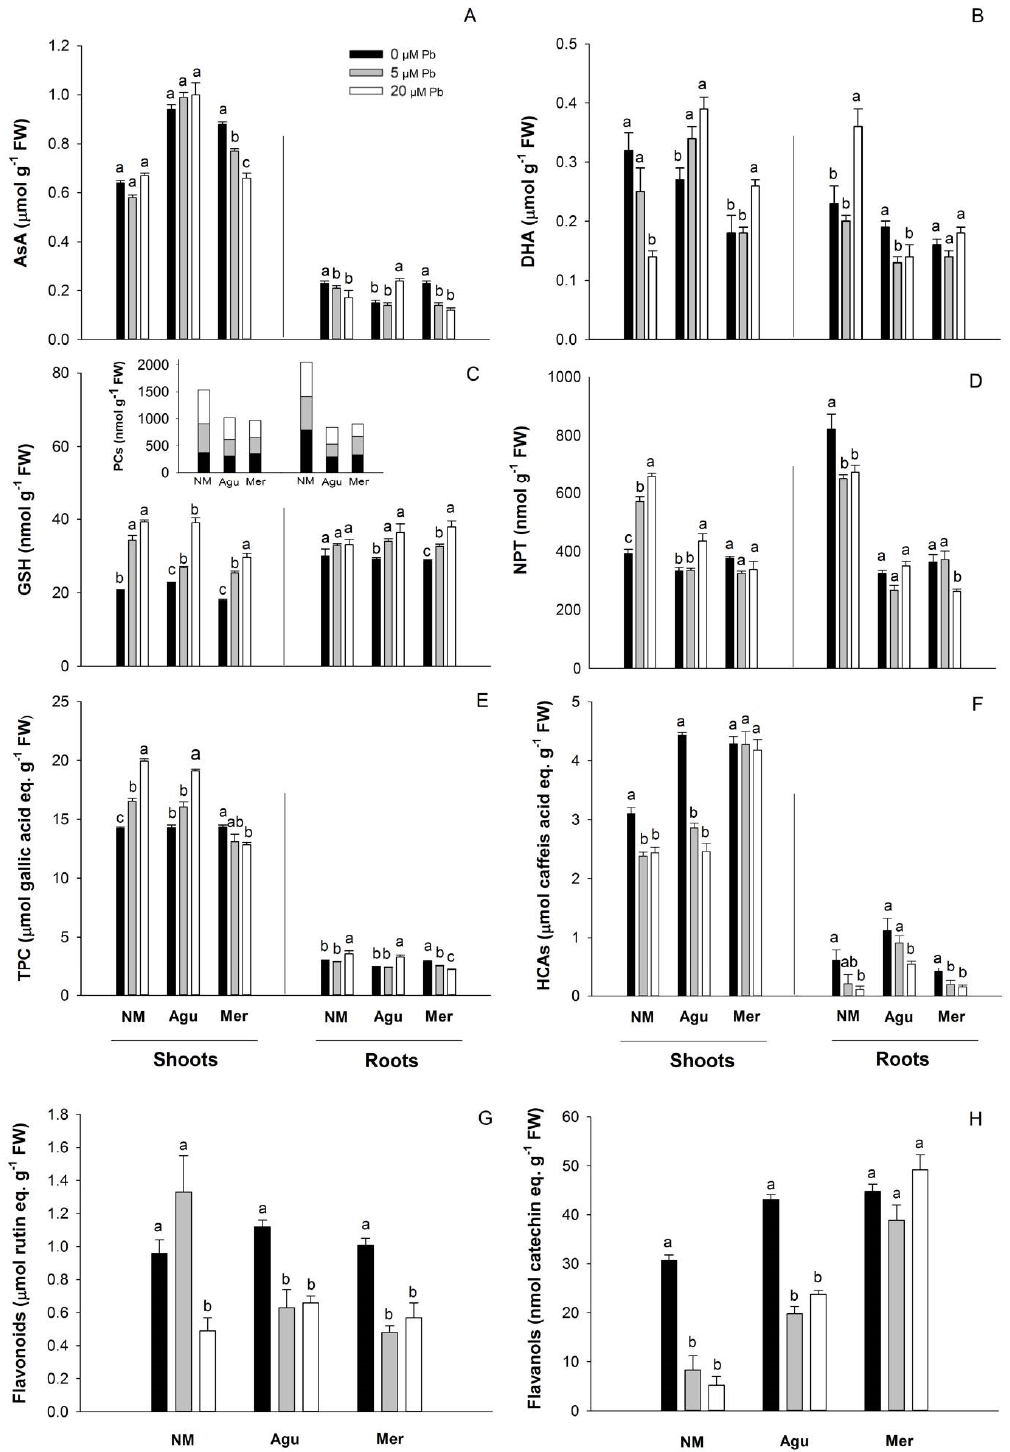
Figure 6. Redox profiles of the nonmetalliferous (NM) and metalliferous (M) populations of Z. fabago seedlings exposed for 4 weeks to low doses of Pb. Contents of AsA (ascorbate; ( A )), DHA (dehydroascorbate; ( B )), reduced glutathione (GSH) and phytochelatins (PCs; insert) ( C ), soluble total non-protein thiols (NPT; ( D )), total soluble phenolics (TPC; ( E )) and hydroxycinnamic acids (HCAs; ( F )) in shoots, roots and flavonoids ( G ), as well as flavanols ( H ) contents in shoots of non-mining (NM) and mining Agustin (Agu) and Mercader (Mer) Z. fabago populations exposed to 0, 5 and 20 µ M Pb(NO 3 ) 2 for 4 weeks. Values are given as mean ± SE. Different letters correspond to significant differences between doses within the same population and organ ( p <